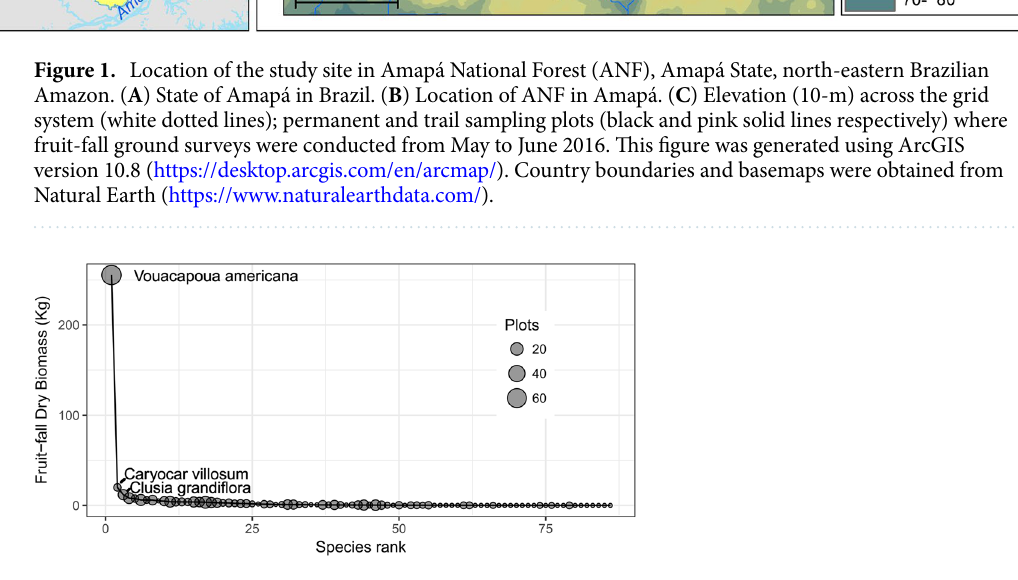
Figure 2. Vouacapoua americana fruit-fall dominance. Distribution of species ranked by fruit-fall dry biomass collected in 90 survey plots in the Amapá National Forest from May to June 2016. Size of spheres proportional to the number of plots where each species was recorded.